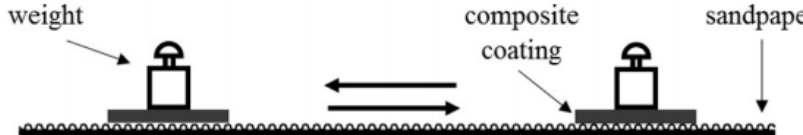
Figure 7. Crosshatch tape adhesion test for the composite coating.